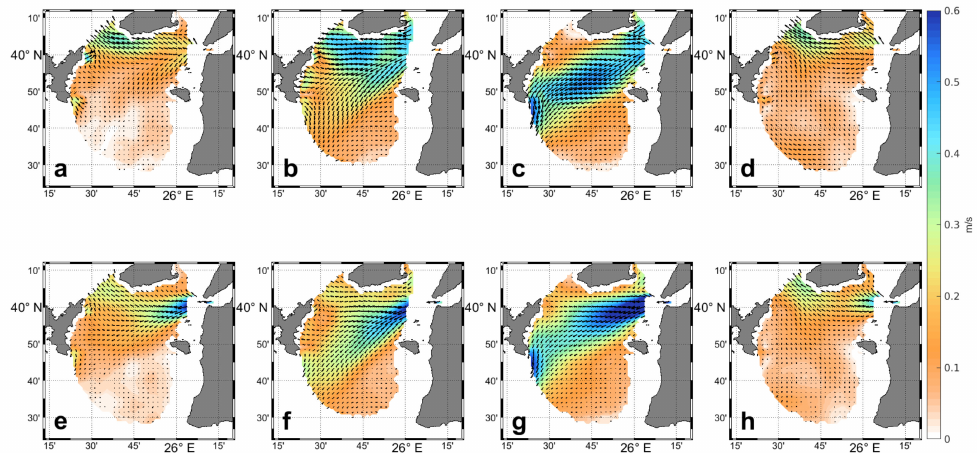
Figure 17. Dardanelles exit seasonal surface velocity for 2010. Upper panels show the HF Radar velocity fields and lower panels the simulation output. The four columns correspond to winter (JFM), spring (AMJ), summer (JAS) and fall 2010 (OND), from left to right. Upper panels ( a – d ) refer to observations and lower panels ( e – h ) to model